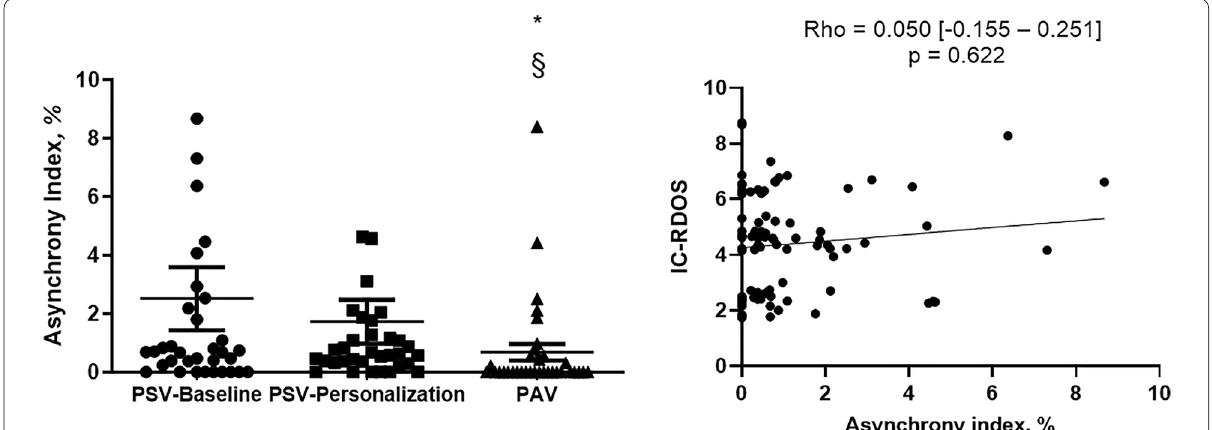
Fig. 3 Individual asynchrony index (A) at baseline (PSV‑Baseline), after personalization of ventilator settings (PSV‑Personalization) and with proportional assist ventilation (PAV); correlation between the individual asynchrony index and Intensive Care‑Respiratory Distress Observation Scale (IC‑RDOS) (B). The horizontal solid line indicates median value. * p < 0.05 compared to PSV‑Baseline, § p < 0.05 compared to